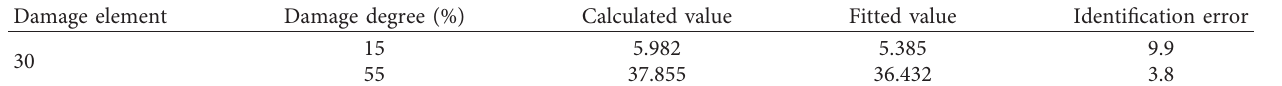
Table 4: Validation of single damage degree function equation.